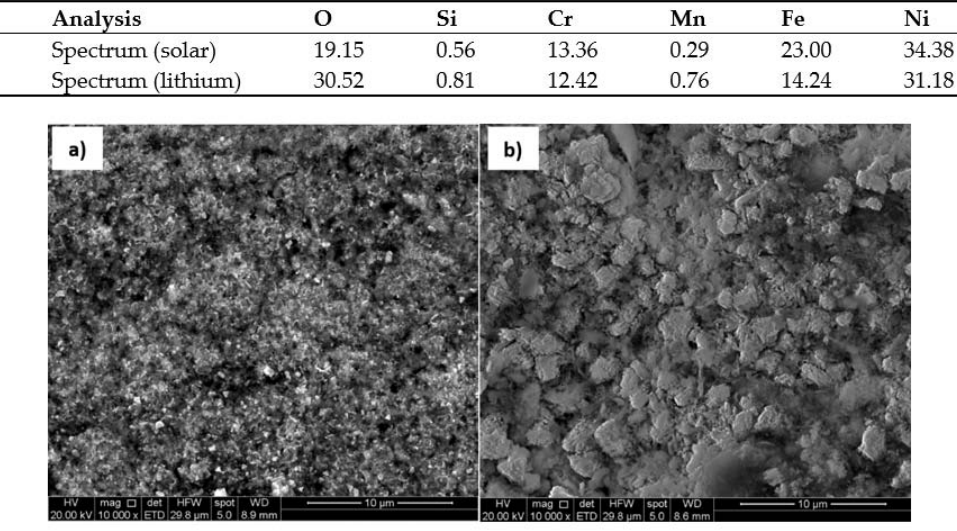
Figure 20. Surface of HR-224 Nickel alloy in ( a ) Solar Salt ( b ) LiNaKNO 3 , at 550 ◦ C after 100 h. Appl. Sci. 2020 , 10 , x FOR PEER REVIEW Figure 20. Surface of HR ‐ 224 Nickel alloy in ( a ) Solar Salt ( b ) LiNaKNO 3 , at 550 °C after 100 h. Figure 20. Surface of HR ‐ 224 Nickel alloy in ( a ) Solar Salt ( b ) LiNaKNO 3 , at 550 °C after 100 h.